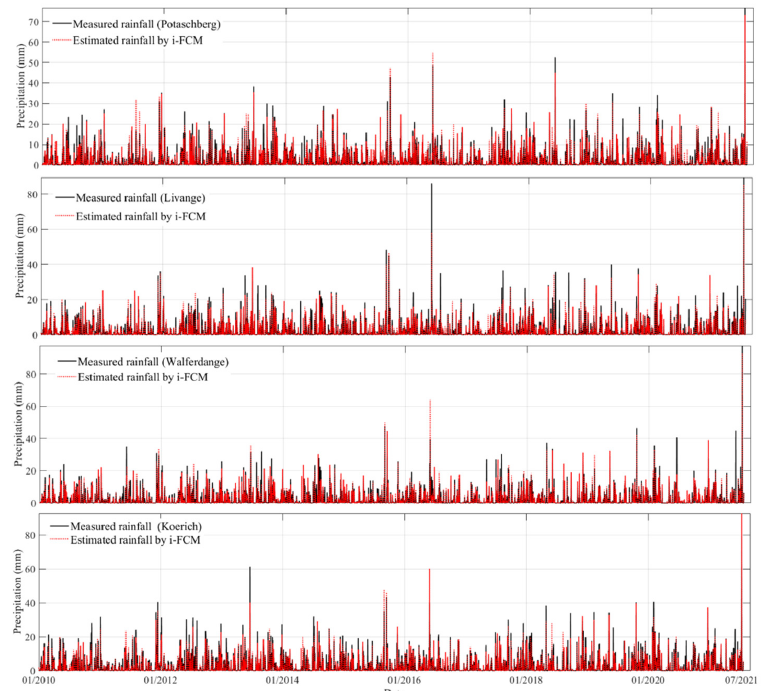
Figure 7. Measured and estimated daily rainfall data in validation stations.